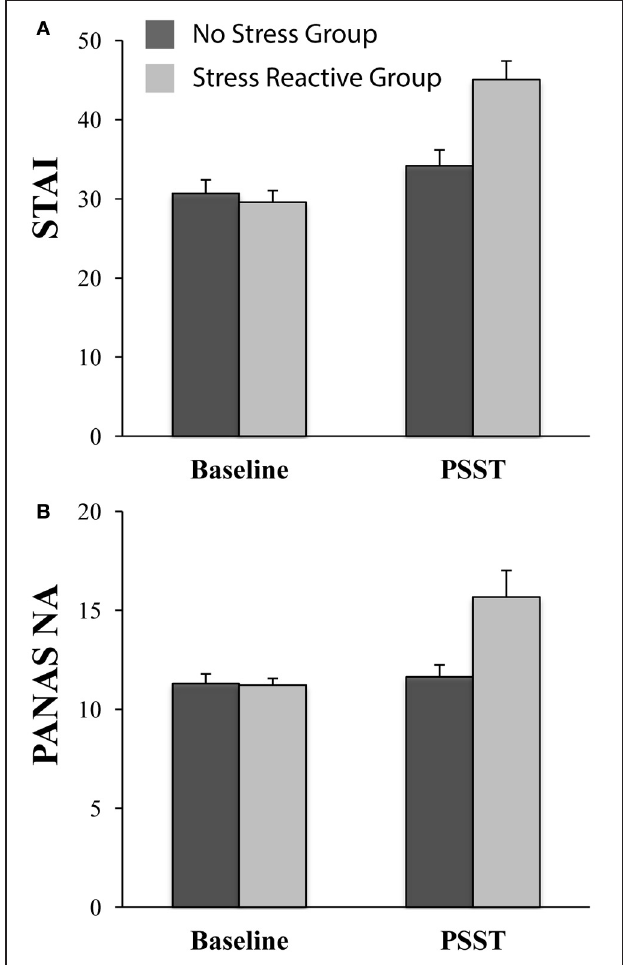
FIGURE 4 | Performance on “Choose A” and “Avoid B” trials during the PSST test phase in the no-stress ( n = 27) and stress-reactive ( n = 18) groups. (A) Accuracy; (B) Reaction Time (in